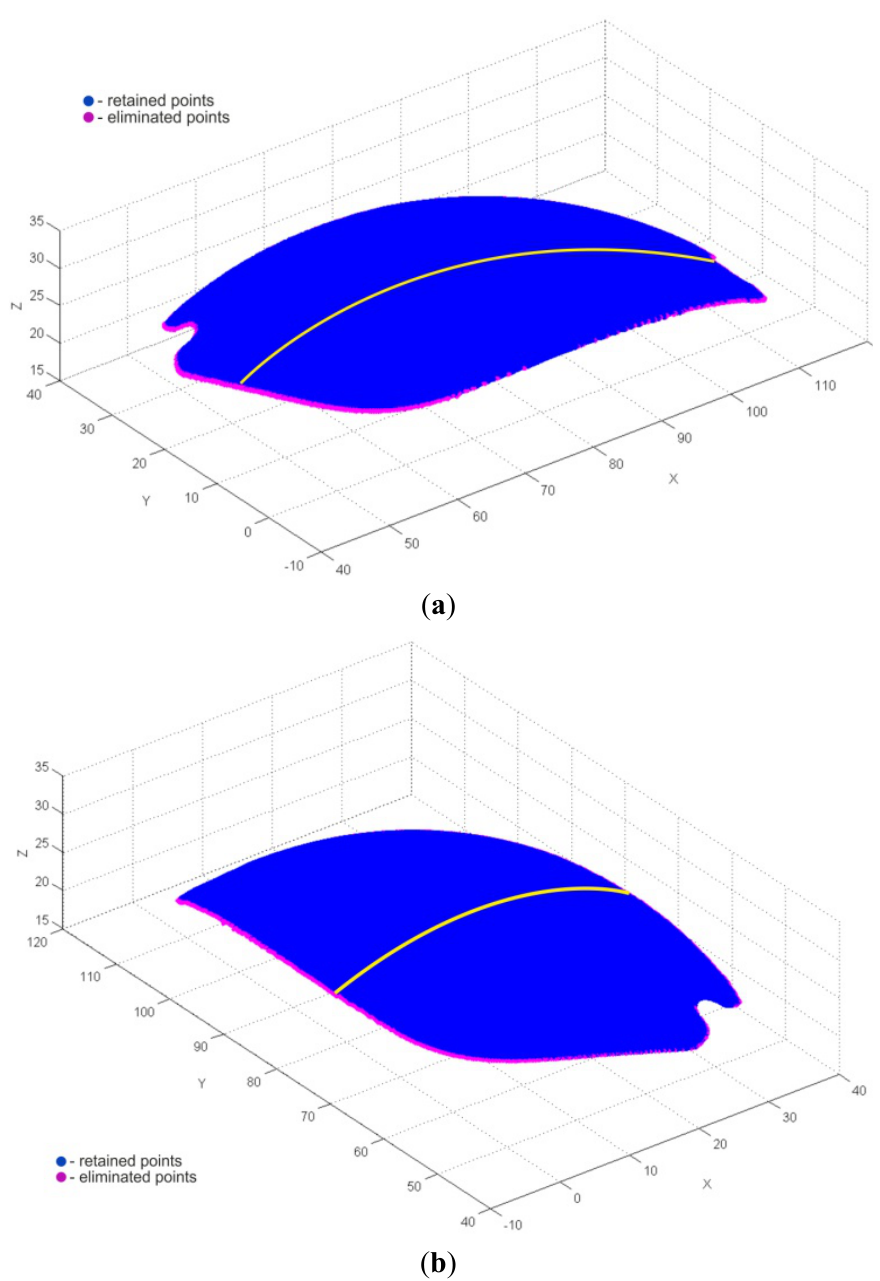
Figure 23. Elimination of end-points in cross-sections. ( a ) 1st iteration—along y axis. ( b ) 2nd iteration—along x